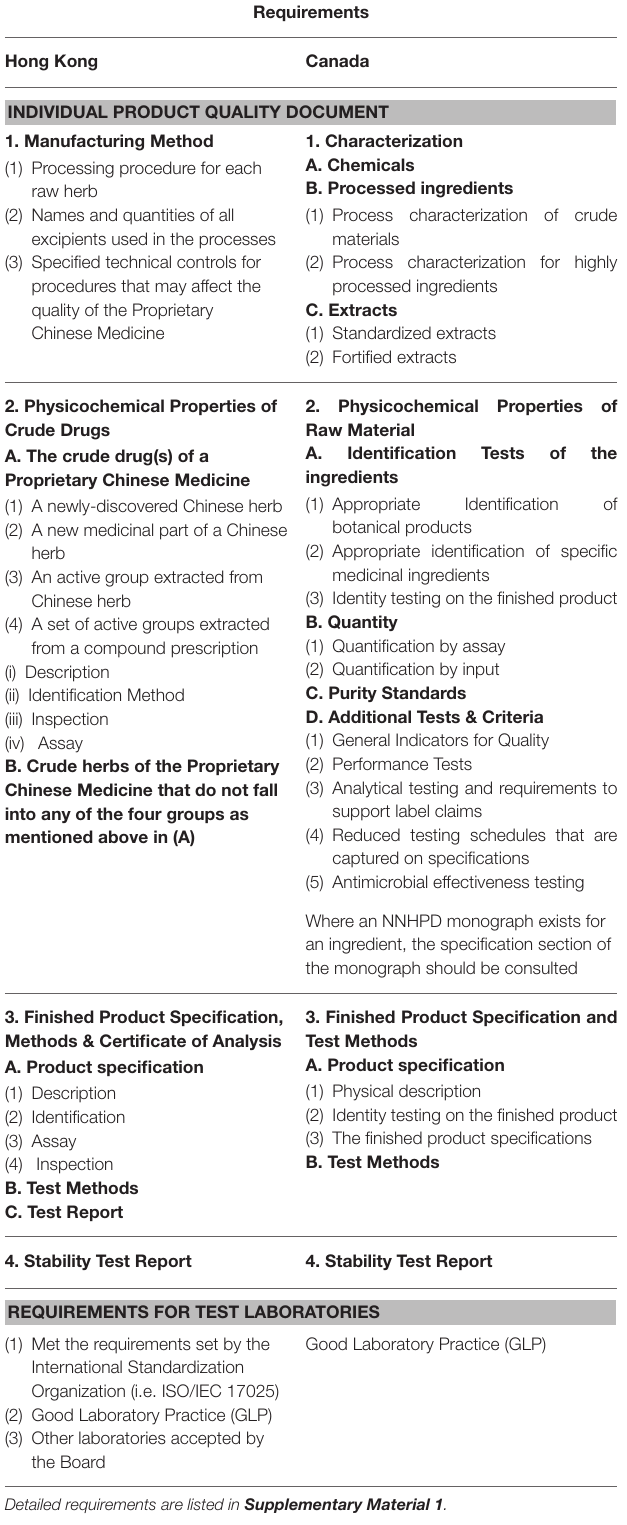
TABLE 2 | The quality requirements of proprietary Chinese medicines in Hong Kong and Canada (10,